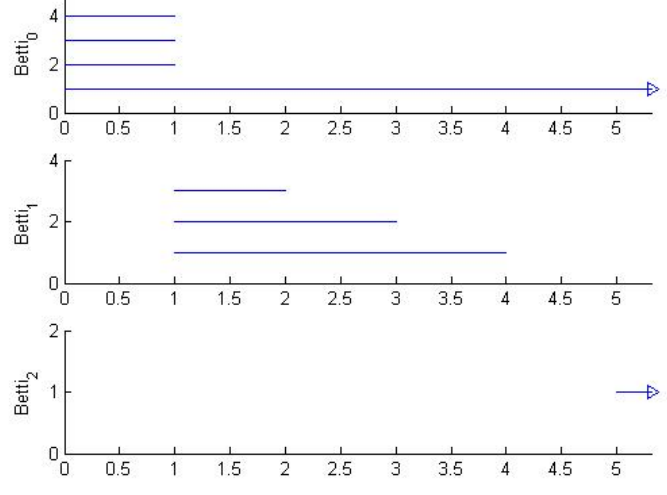
Figure 1. The barcodes for a filtration of the boundary of the